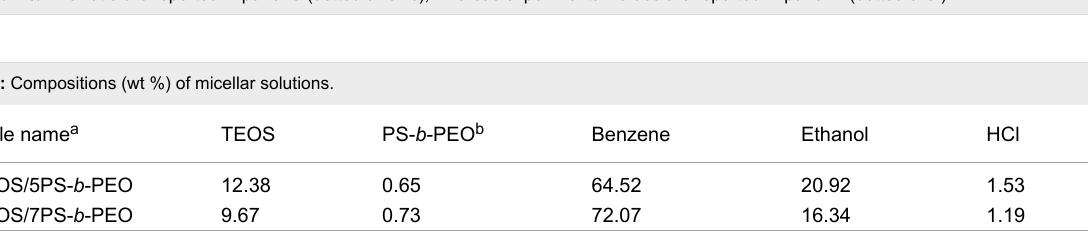
Figure 4: Evaluation of the pore size (nm ± SD) as a function of the PS/PEO ratio (A, C, D) and logarithm of pore size vs logarithm of the PS/PEO ratio (B) for the 95TEOS/5PS- b -PEO (black circles) and 93TEOS/7PS- b -PEO (white circles) samples. In particular, the equations in panels A and B refer, from top to bottom, to the 95/5 (dashed line) and 93/7 (dotted line) experimental fitting curves, respectively. Reliability of regressions: R 2 > 0.98 and 0.83 (A), R 2 > 0.96 and 0.88 (B). Black square in panel A is the zoomed area reported in panel C. Calculations of the pore size for the sample with 0.89 PS/PEO ratio are reported in panel C (dotted arrows), whereas experimental values are reported in panel D (dotted oval).